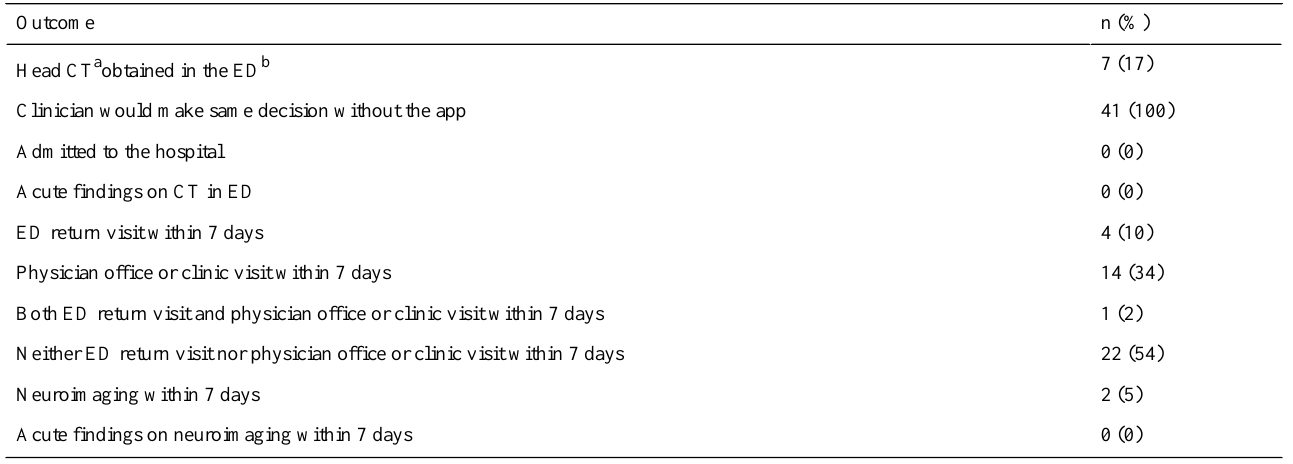
Table 6. Health care utilization and patient safety